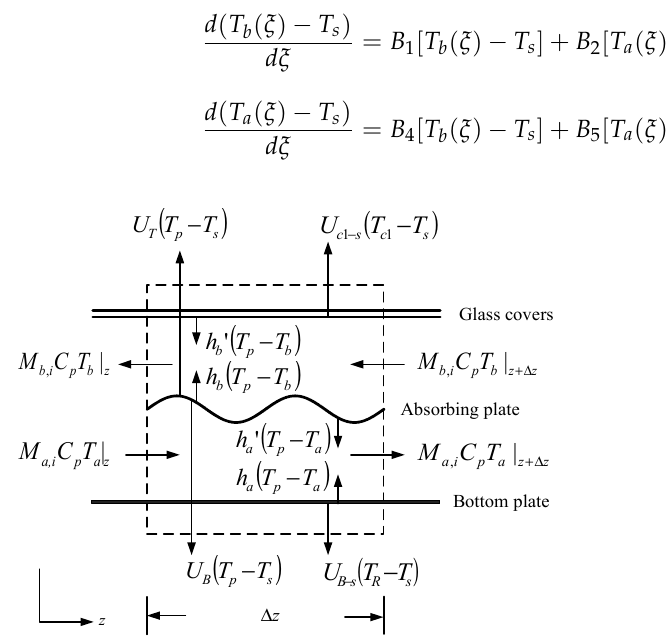
Figure 3. The energy balance achieved within a finite fluid element.